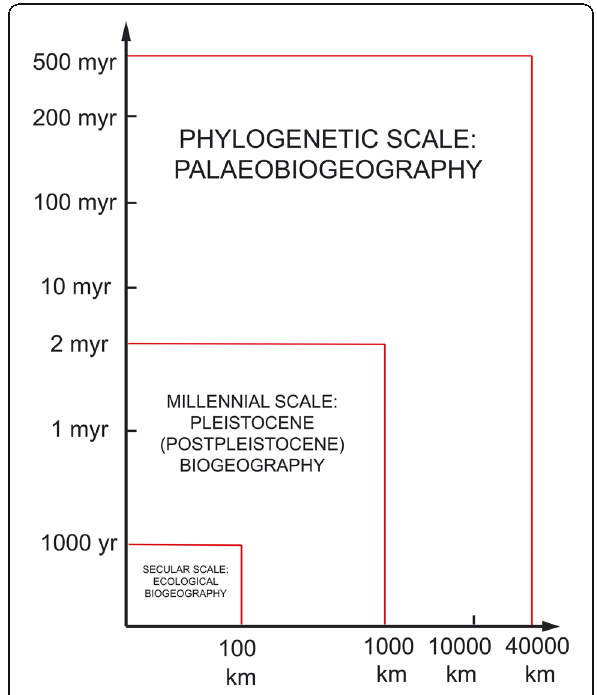
Fig. 7 Division of biogeography into the three spatial-temporal scales of Udvardy (modified from Udvardy